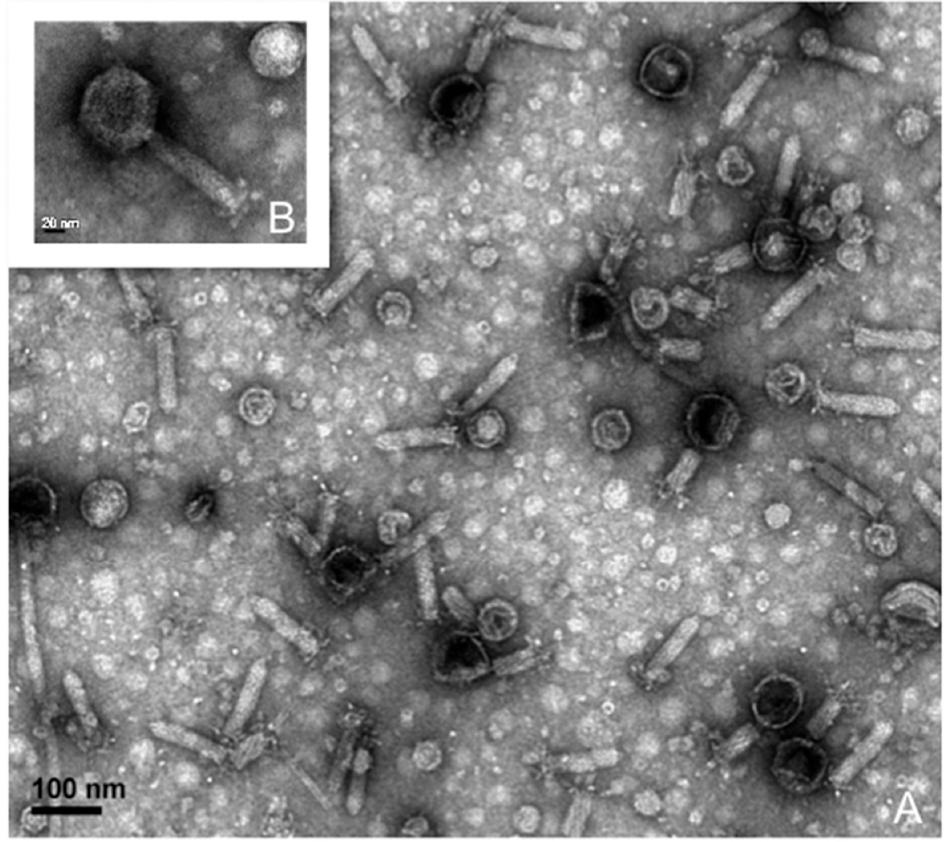
Figure 5. ( A ) TEM image of a pure culture of lytic phage, SFCi1, indicates that it is a myophage. ( B ) Magnified image of a single viral particle outlining the icosahedral head and details of the contractile tail and baseplate.